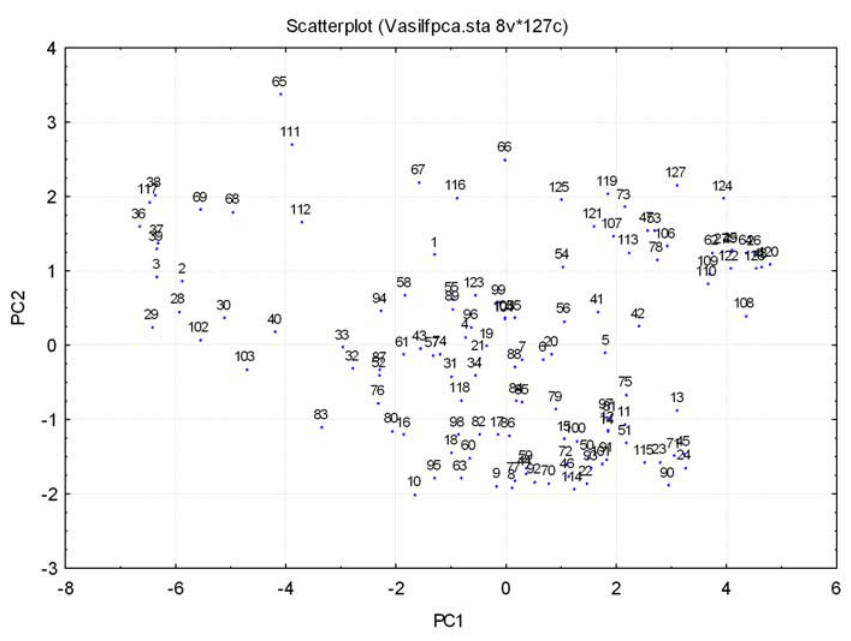
Fig. 6 Scatter plot of scores corresponding to the first two principal components (Or- thogonal Fuzzy